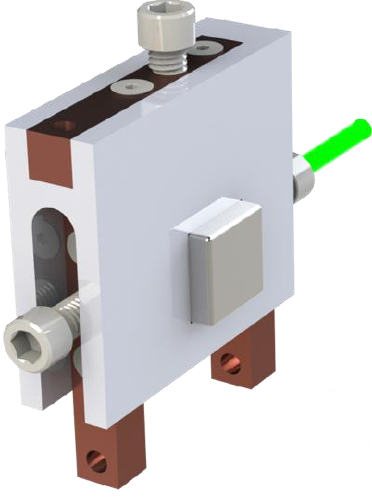
Figure 3. Render of a plasma switch.